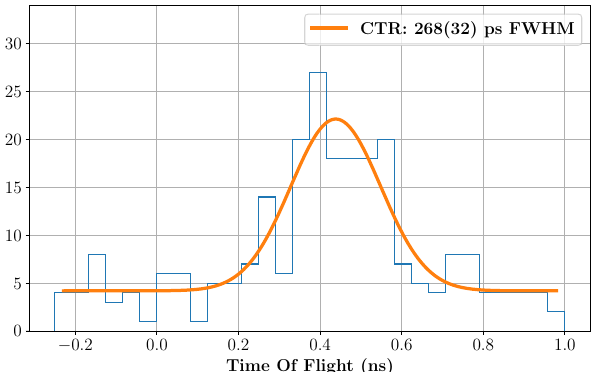
Figure 4. TOF distribution obtained with the 5 mm thick, 10 cm radius PMMA target irradiated by 63 MeV protons. The PG detector consisted of a 1 cm 3 PbF 2 crystal coupled to a 3 respect to the beam. Data are fitted with a gaussian distribution convolved with a uniform distribution of 51 ps width. The resulting FWHM of 268 ps (114 ps rms) corresponds to the gaussian distribution FWHM and it can be interpreted as the system